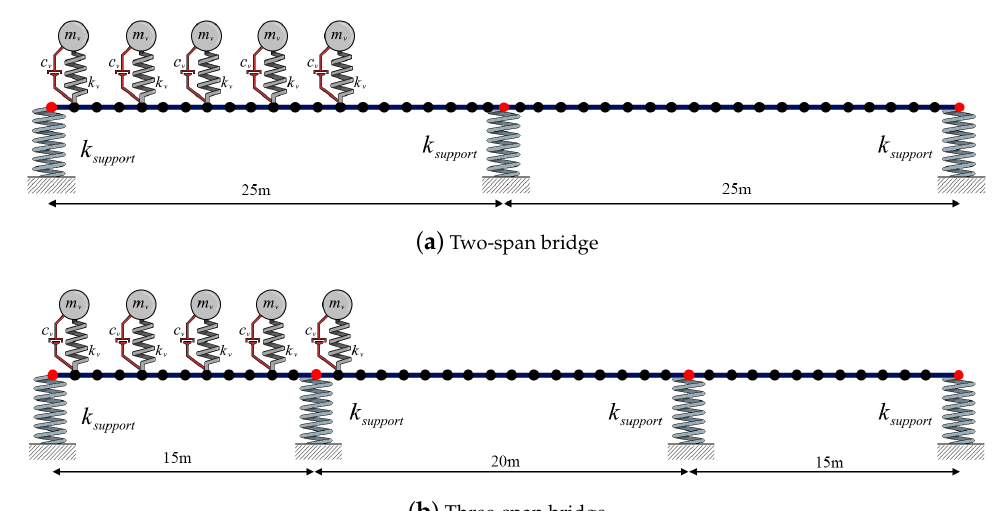
Figure 4. Overview of the multispan bridges.